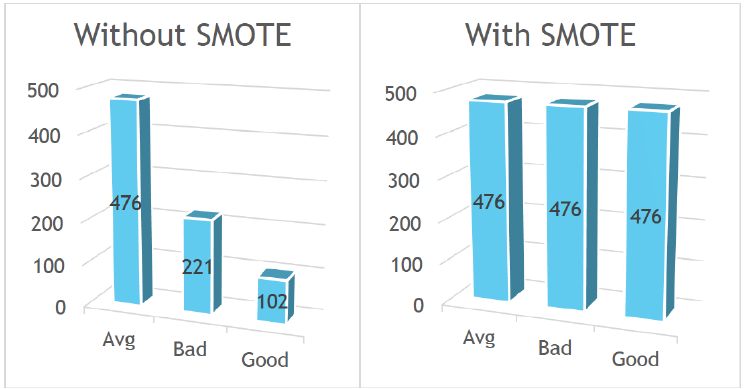
Figure 6. Dataset Records without-SMOTE and with-SMOTE.